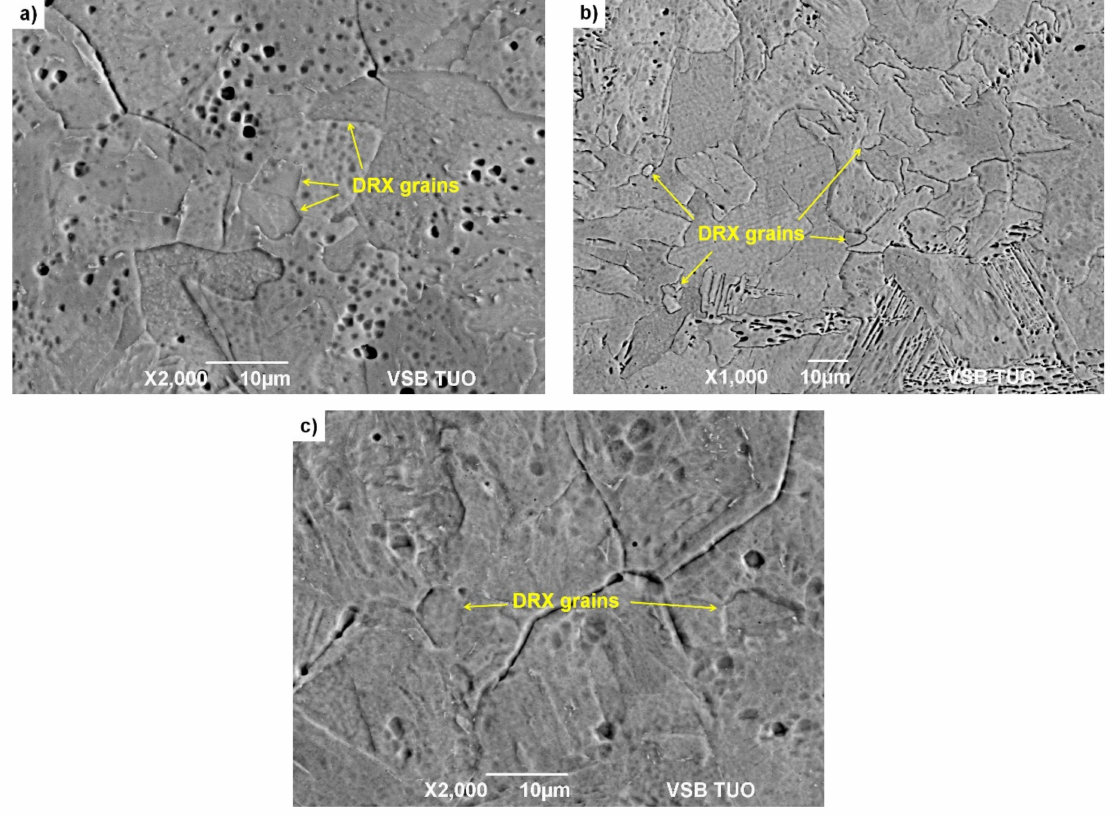
Figure 9. Metallographic images with etched boundaries of original austenitic grains of steel A: . ε = 0.05 s − 1 , ε = 0.13; ( b ) T d = 1050 ◦ C, ( a ) T d = 950 ◦ C, ε =